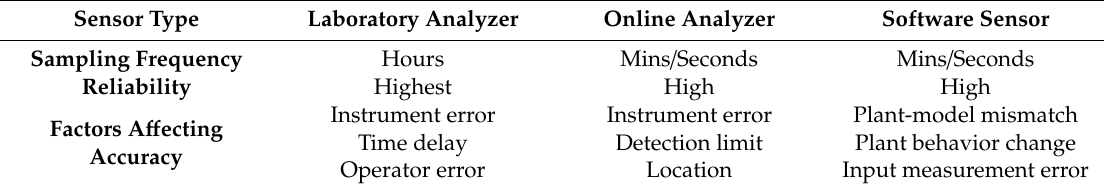
Table 1. Typical hard and soft sensors applied to monitoring chemical